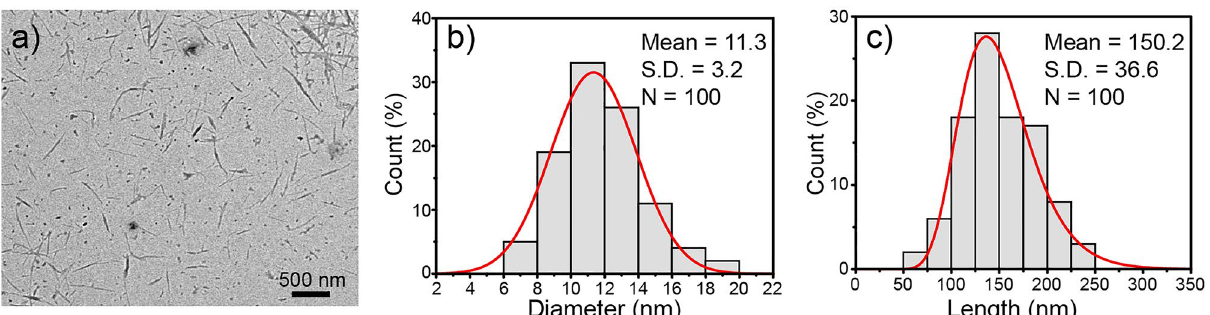
Figure 6. Morphology and dimensions of VCNC; ( a ) TEM, ( b ) diameter distribution, and ( c ) length